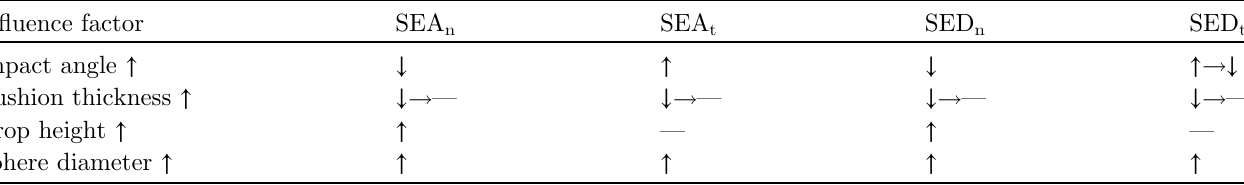
Table 2. Relationships of normal and tangential speci fi c energy parameters with different in fl uence factors. In fl uence factor